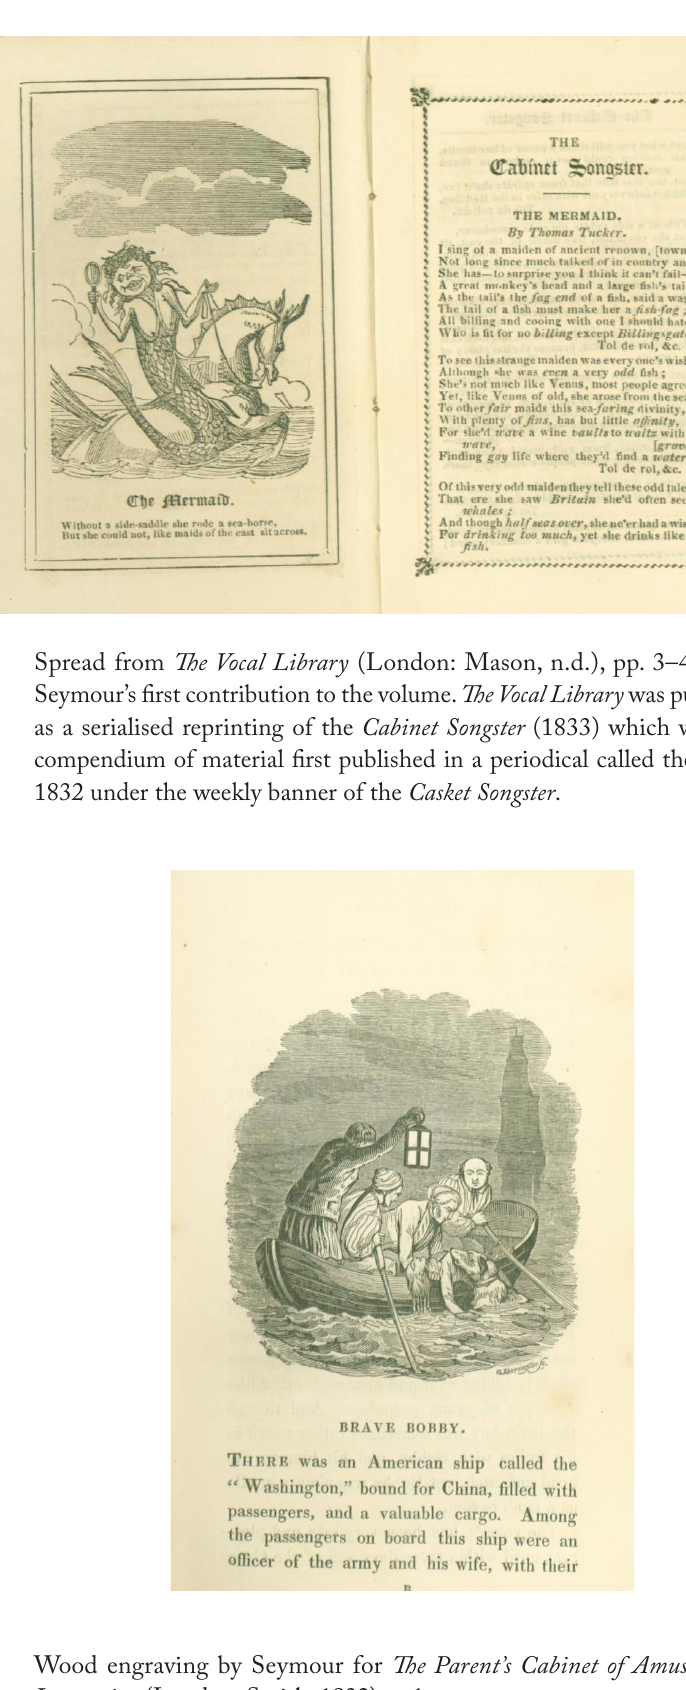
Fig. 3 Wood engraving by Seymour for The Parent’s Cabinet of Amusement and Instruction (London: Smith, 1832), p.